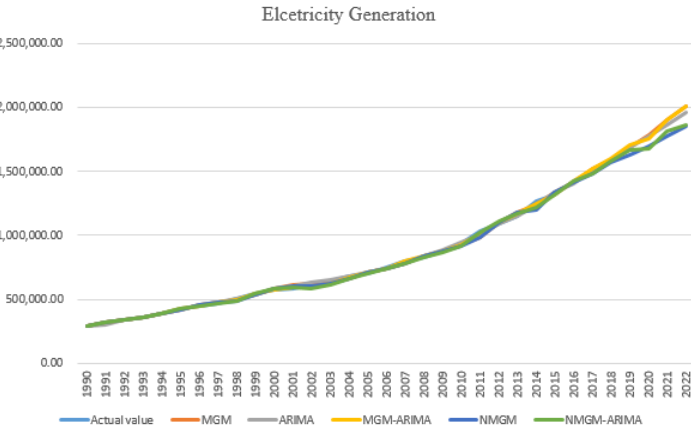
Figure 20. The predicted value of the five models and the actual power generation. (Line chart, GWh).